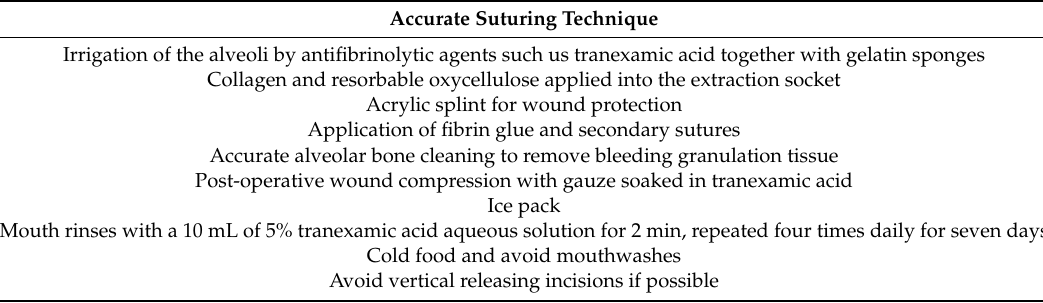
Table 8. Precautions to improve